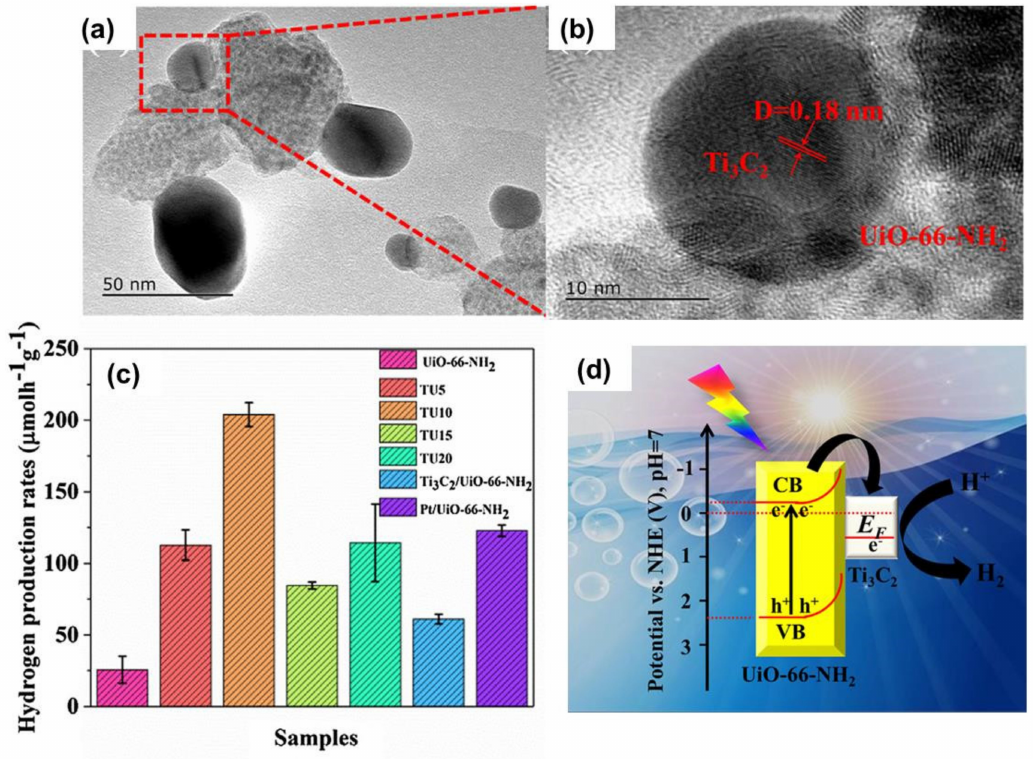
Figure 7. ( a , b )TEM images presented the formation of Ti 3 C 2 T x and Zr-MOFs heterostructure; ( c ) HydrogenproductionratesofTi 3 C 2 T x / Zr-MOFwithdi ff erentconcentrationsofTi 3 C 2 T x ; ( d )Energyband diagram of Ti 3 C 2 T x / Zr-MOF for photocatalytic HER. Reproduced with permission from reference [82]. Copyright Elsevier B.V.,